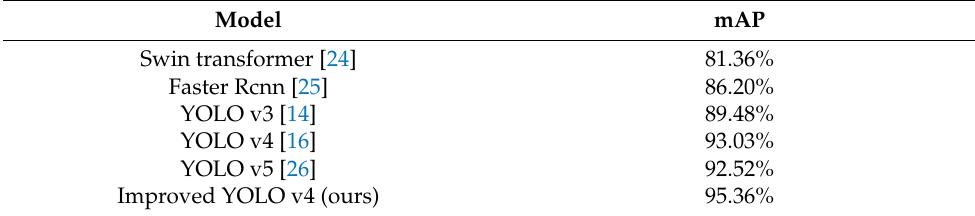
Table 2. The results of different